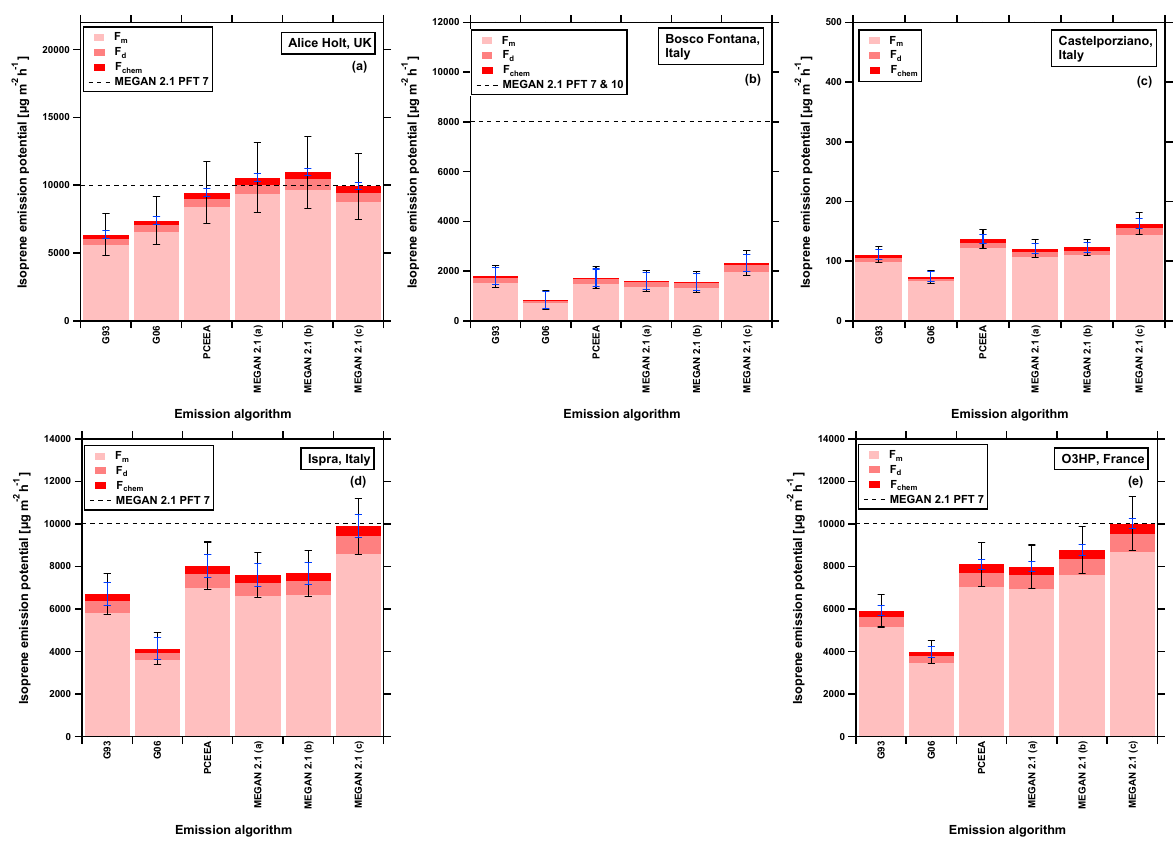
Figure 4. Graduated bars representing the ecosystem specific isoprene emission potentials ( ε eco ) at each of the five measurement sites. Each bar shows (i) the calculated emission potential based on measured fluxes ( F m ) , (ii) the correction applied for dry deposition ( F d ) and (iii) the correction applied for chemical flux divergence ( F chem ) . For each site emission potentials were calculated using six implementations of the Guenther algorithms (see Sect. 2.2 for details) and are shown relative to the relevant plant functional type emission potential in MEGAN 2.1 (black line). Note that for the Castelporziano site this value is at 1839µgm − 2 h − 1 and is off scale. The blue error bars show the uncertainty in the emission potential that relates to the random error in the observed flux measurements. The black error bars show the total uncertainty (random and systematic errors). MEGAN 2.1 (a) is the full implementation of the model using calculated leaf temperature. MEGAN 2.1 (b) is the full implementation of the model using air temperature. MEGAN 2.1 (c) is a version of the model where only the effects of current environmental conditions (e.g. light and air temperature) are